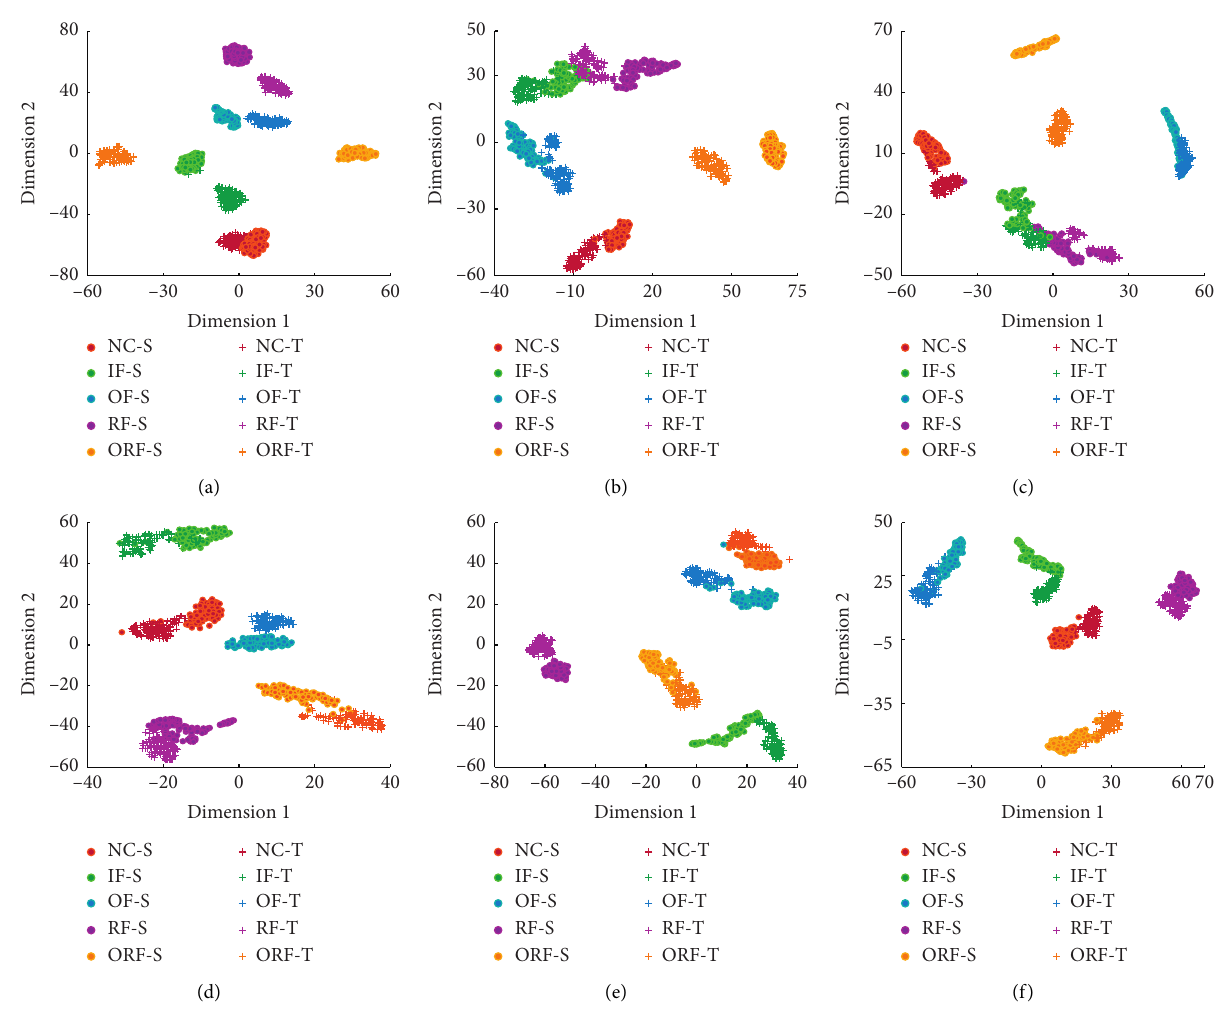
Figure 6: Scatter diagram in case A ⟶ B: (a) SAE, (b) TCA, (c) DANN, (d) MK-MMD, (e) SFDA and (f) DAAN.